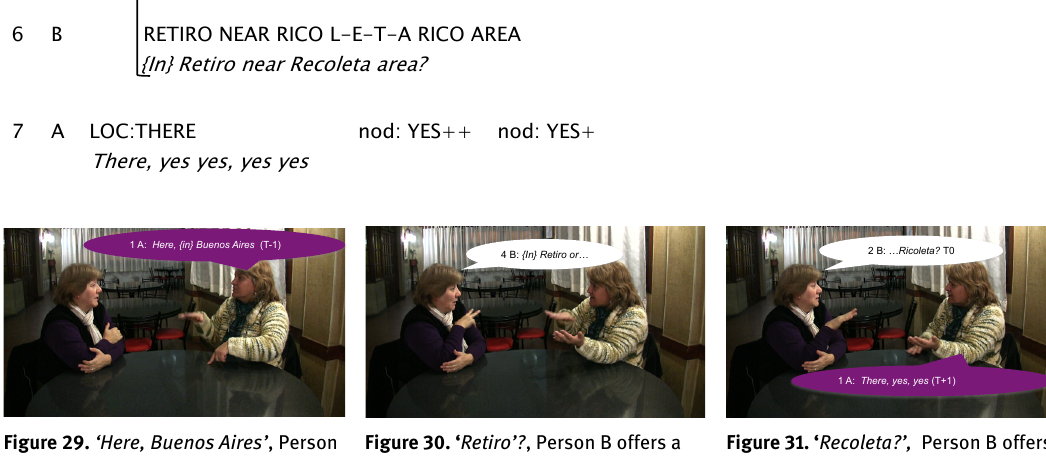
Figure 29. ‘Here, Buenos Aires’ , Person A (right), produces a trouble source turn, line 1.